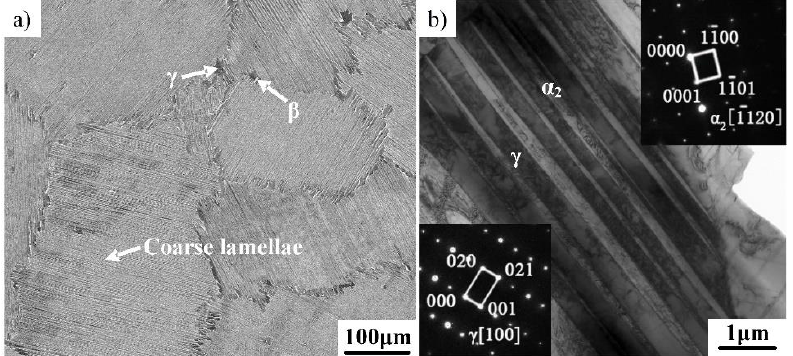
Figure 1. Microstructural characterization of the Ti–43Al–3Mn–2Nb–0.1Y ingot. ( a ) SEM images and ( b ) TEM images.